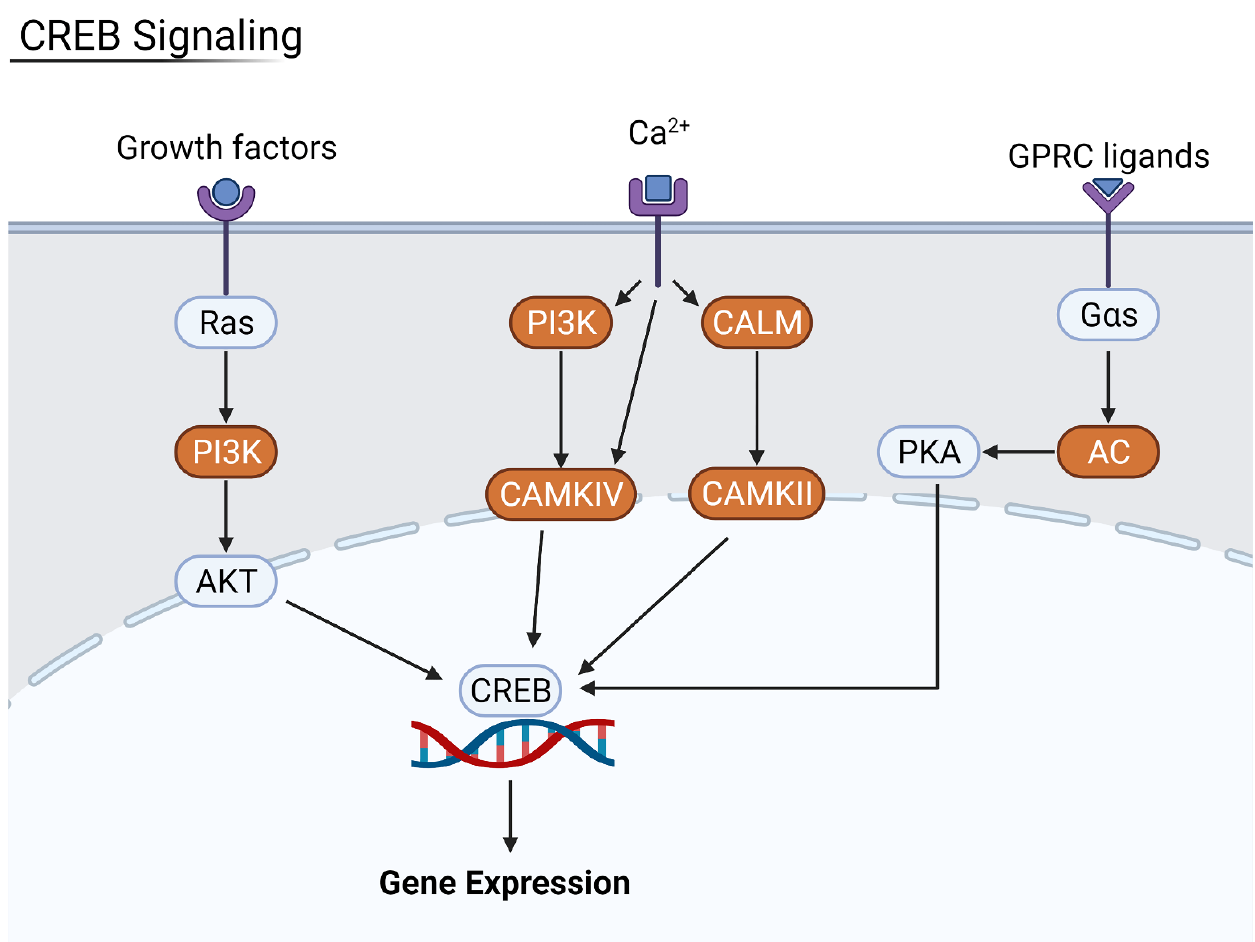
Figure 9. Summary of the CREB signaling pathway. Key kinases such as PI3K were upregulated in more severe patients, leading to an increase in CREB-directed gene expression. Generated in Biorender.